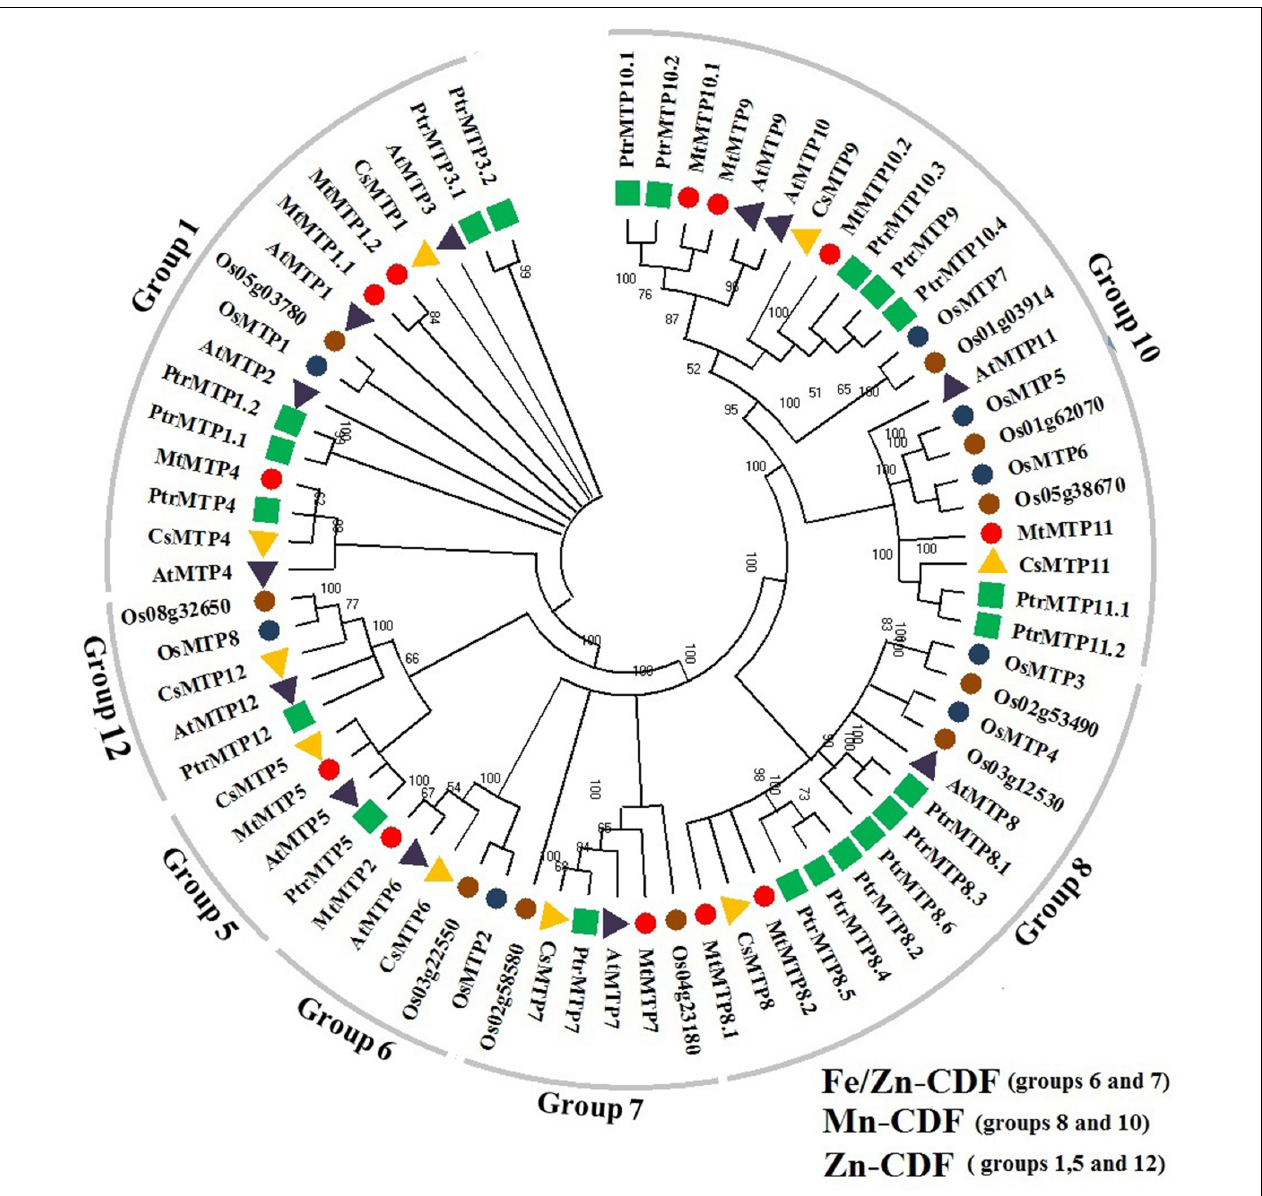
FIGURE 1 | Phylogenetic tree of 72 MTP proteins: 12 M. truncatula (marked by red circle), 12 Arabidopsis (purple triangle), 8 wheat (blue circle), 10 rice (brown circle), 9 cucumber (yellow triangle), and 21 black poplar (blue square). ClustalX1.83 was used for protein alignments and the phylogenetic tree’s construction at the neighbor-joining (NJ) level using MEGA6.0.6 software at 1,000 replications